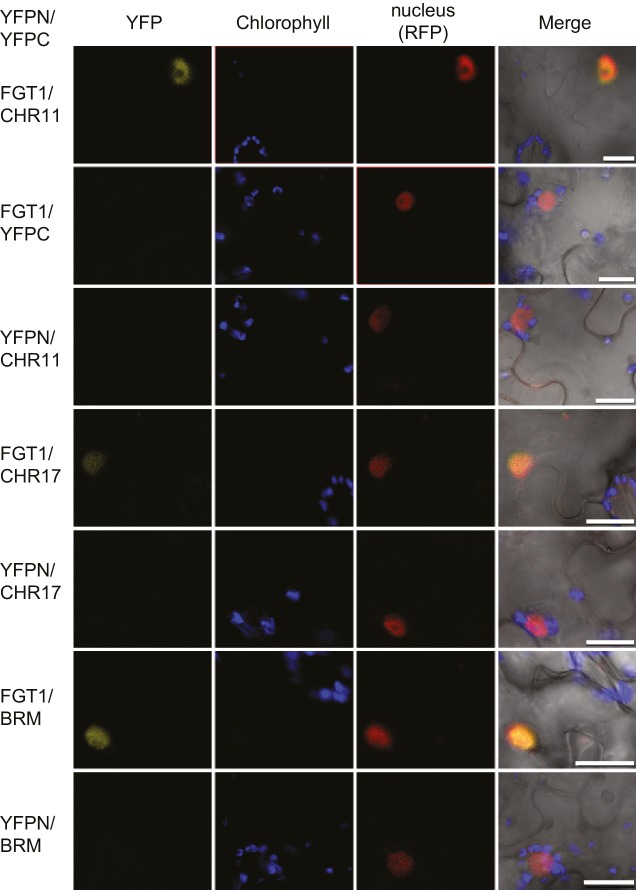
FGT1 interacts in vivo with SWI/SNF (BRM) and ISWI (CHR11, CHR17) chromatin remodeling proteins.Bimolecular Fluorescence Complementation confirms the interaction of FGT1 and CHR11, CHR17 or BRM in the nucleus of tobacco leaf cells. The indicated constructs were co-transformed and analyzed 2 d later with an LSM710 confocal microscope. YFP, BiFC signal in the YFP spectrum; RFP, signal from co-expressed nuclear RFP-fusion protein. Size bar, 20 µm.